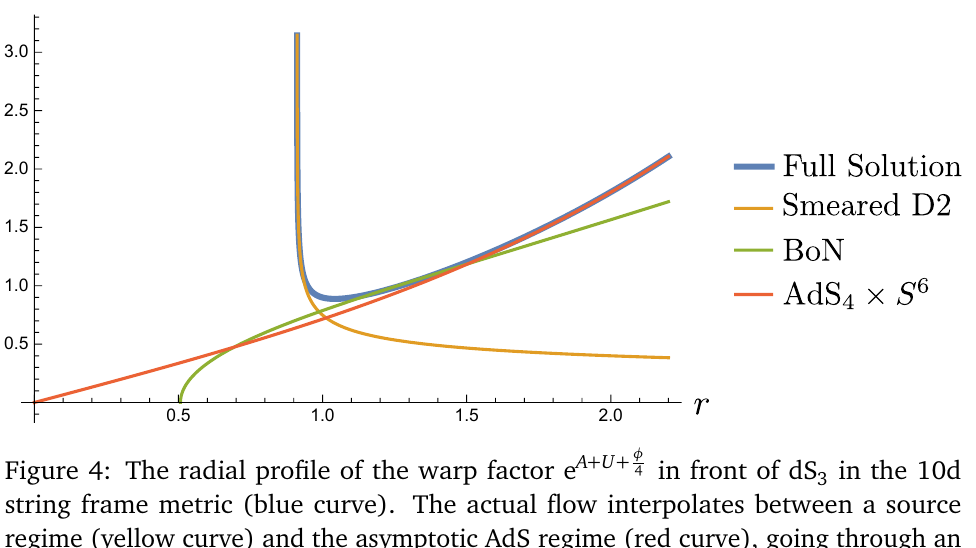
Figure 4: The radial profile of the warp factor e A + U + string frame metric (blue curve). The actual flow interpolates between a source regime (yellow curve) and the asymptotic AdS regime (red curve), going through an intermediate bubble regime (green curve). Similar plots are represented below for the other functions controlling the solution.